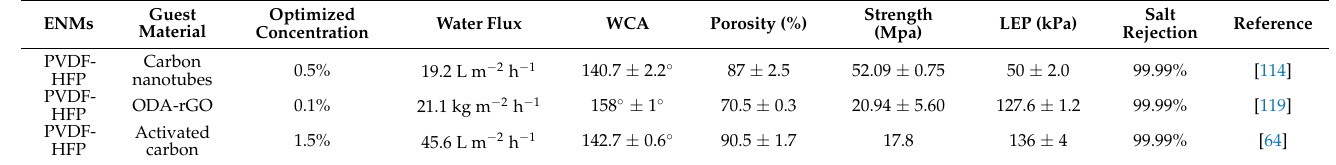
Table 4. Physical properties of ENMs incorporated with CNTs, rGO, and AC for MD.